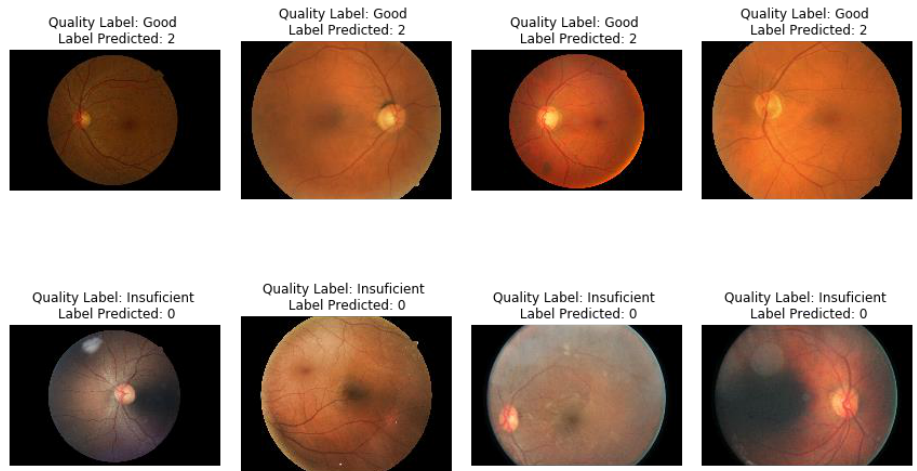
tion subset of 600 images. subset of 600 images.